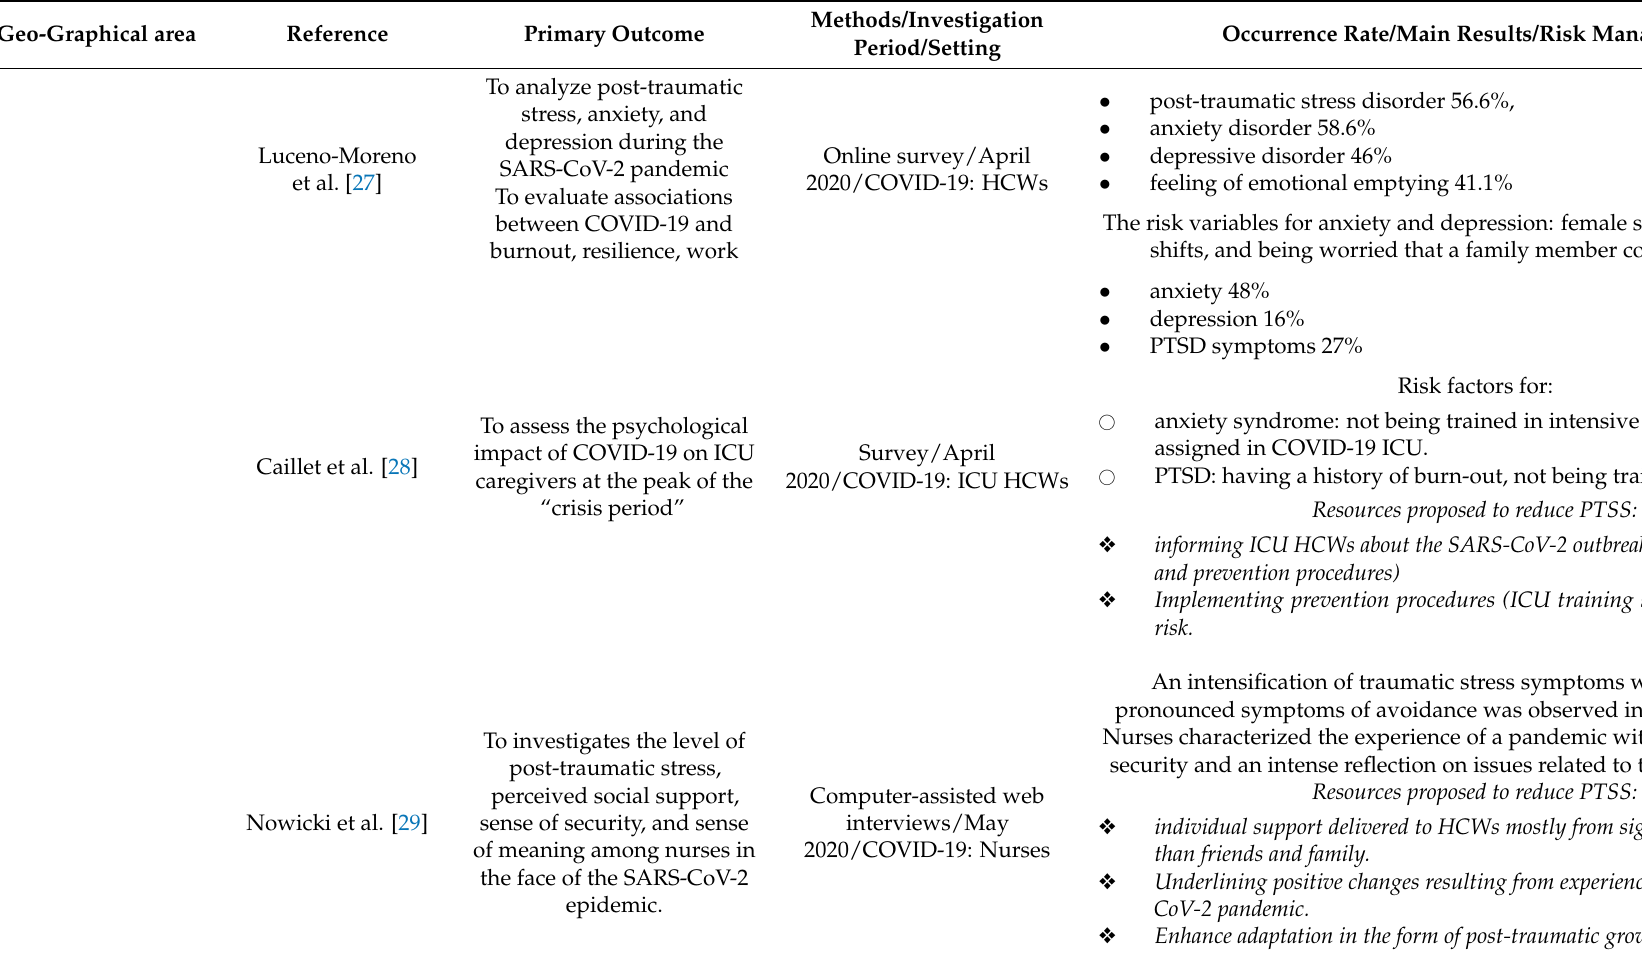
Geo-Graphical area Reference Primary Outcome